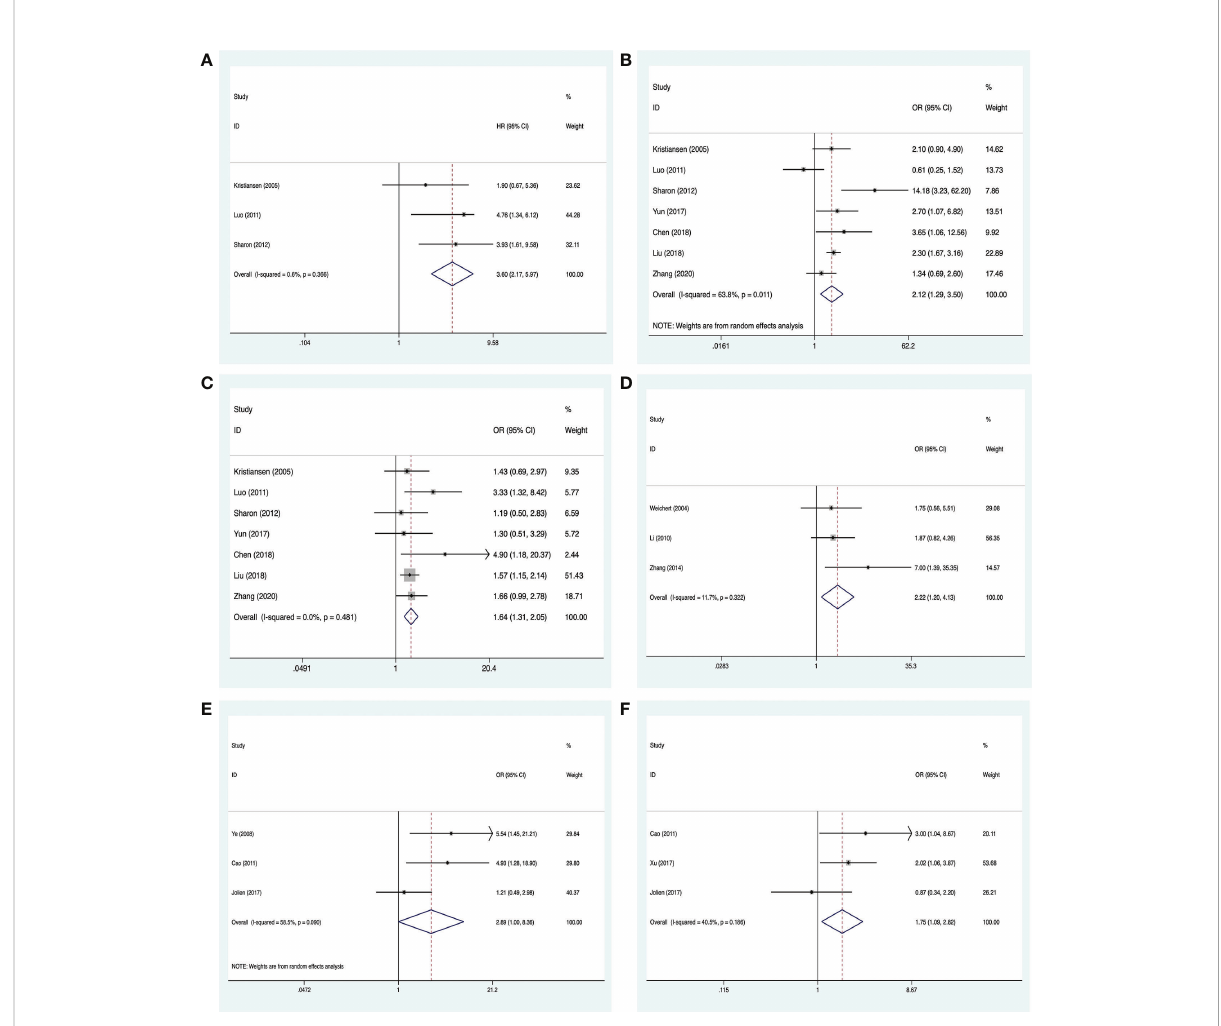
FIGURE 5 Meta-analysis for the association between PLK-1 expression levels, breast cancer, and cancers of the respiratory system and female reproductive system. (A) 5-year overall survival for breast cancer; (B) histological grades in breast cancer; (C) lymph node metastasis in breast cancer; (D) clinical stages in cancers of the female reproductive system; (E) lymph node metastasis in cancers of the respiratory system; (F) clinical stages in cancers of the respiratory